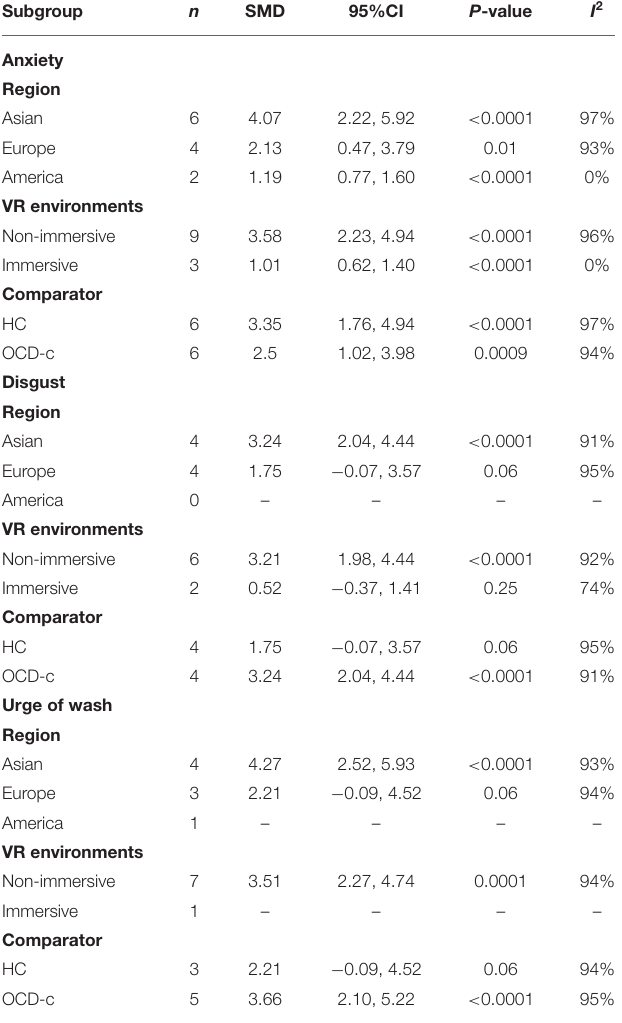
TABLE 3 | Summary statistics for moderators. TABLE 4 | Meta-regression analysis for exploration of the sources of heterogeneity